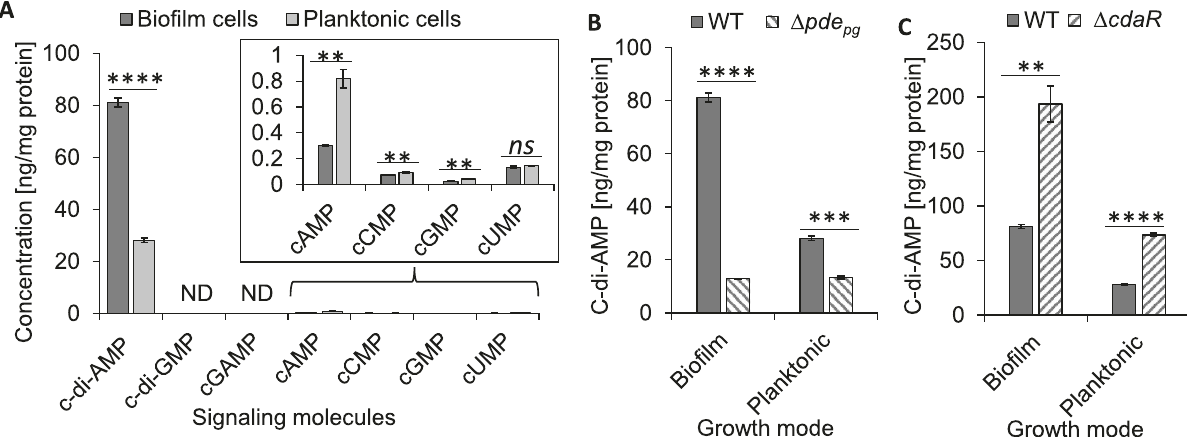
Fig. 1 Comprehensive analysis of cyclic mono- and di-nucleotide second messengers in P. gingivalis 381. A Cellular concentration of ubiquitous bacterial second messengers in the cells of P. gingivalis in bio fi lm or planktonic modes of growth. Mononucleotide second messengers are in the low-nanogram range (inside box). B c-di-AMP in P. gingivalis Δ pde pg . C c-di-AMP in P. gingivalis Δ cdaR . Graphs represent the mean ± SE (three biological replicates) of nucleotide second messengers which were analyzed with a student ’ s t test (** P < 0.01; *** P < 0.001; **** P < 0.0001; ns not signi fi cant). Scatter plots in Supplementary Fig. 9 display the data distribution. Standard curves are presented in Supplementary Fig. 10. ND not detected, WT wild